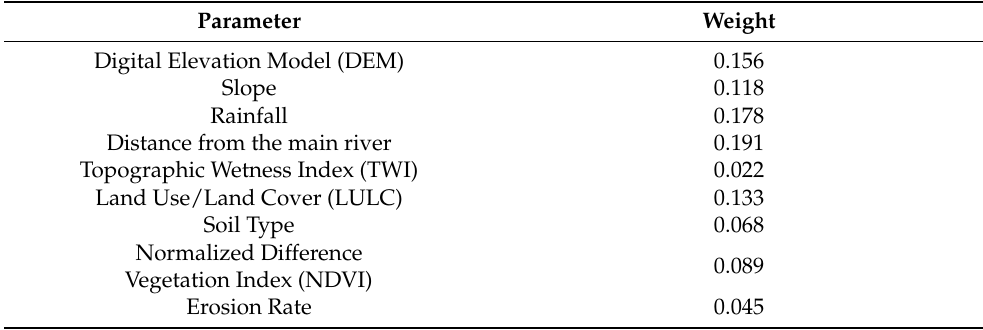
Table 5. The weight value of each input parameter determined using the Analytic Hierarchy Pro- cess